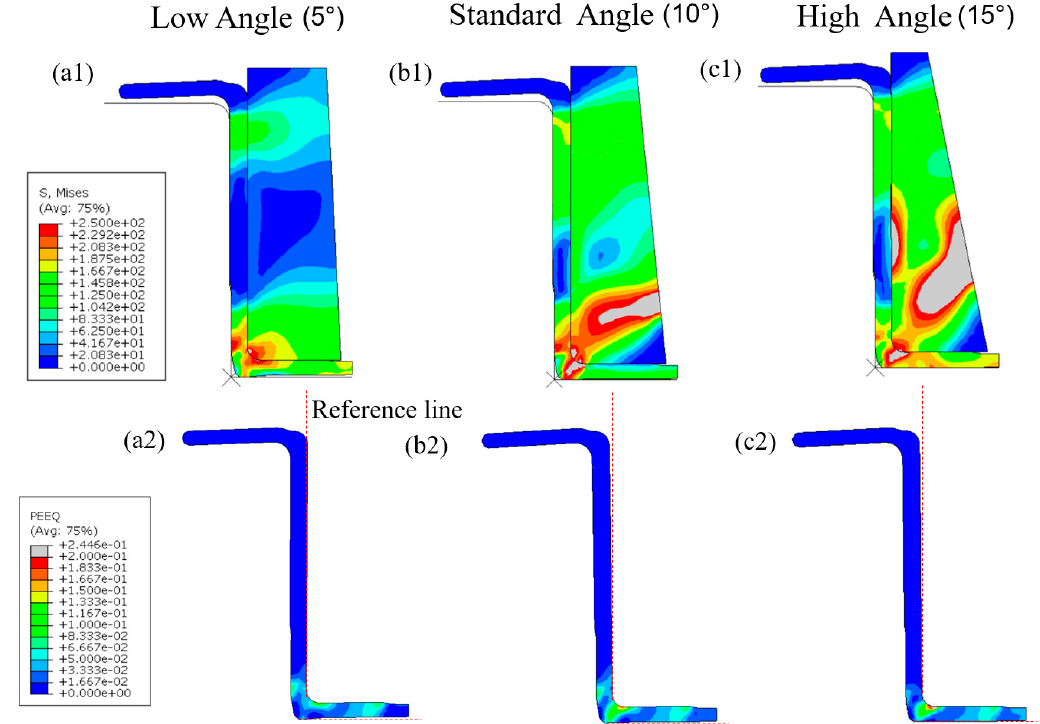
Figure 13. Stress–strain evolution on the profile under three different wedge angles: ( a1 , b1 , c1 ) von Mises stress on the profiles after the calibration and ( a2 , b2 , c2 ) equivalent plastic strain after springback.